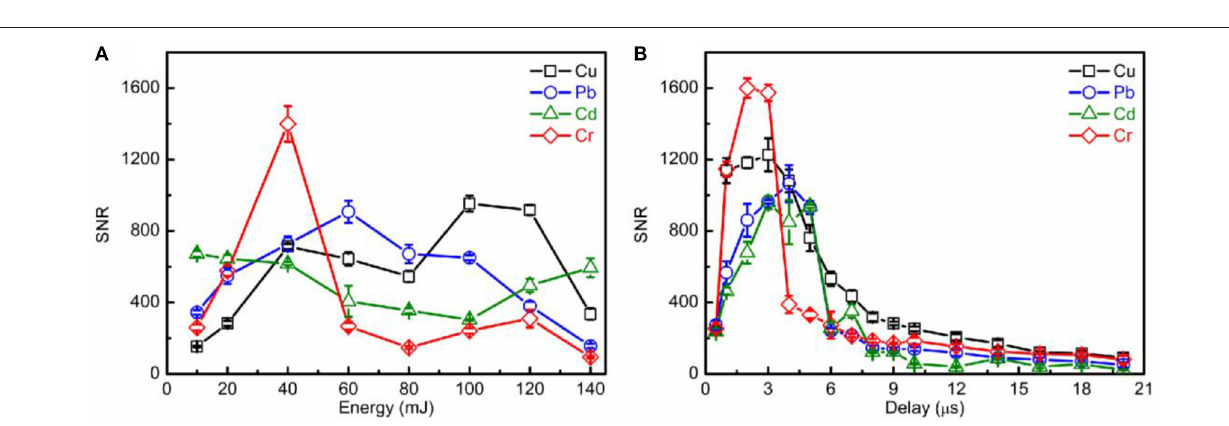
FIGURE 3 | Evolution trends of SNRs for analytical lines (Cu I 324.75nm, Pb I 405.78nm, Cd I 508.58nm, and Cr I 520.84nm) on laser energy (A) and gate delay time (B) .